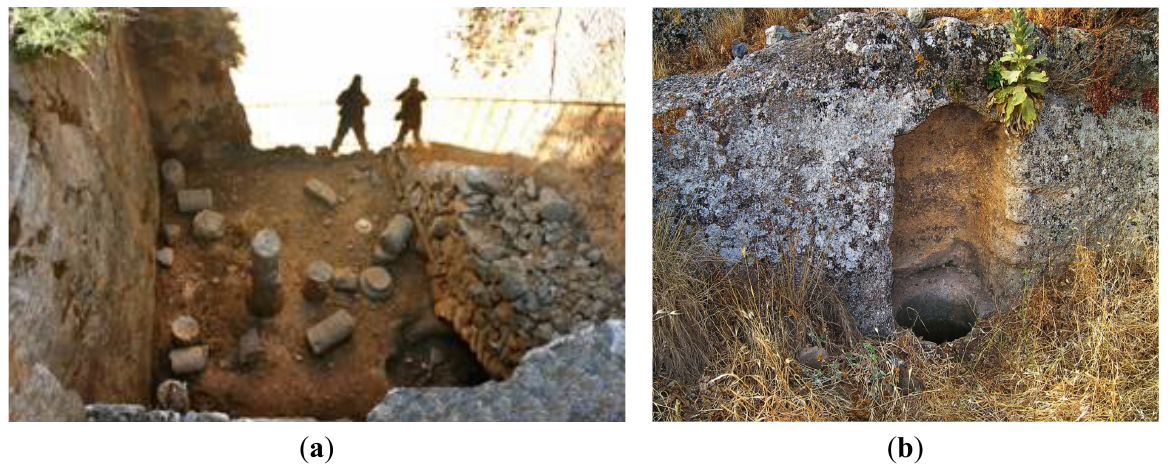
Figure 6. Hellenistic cisterns on Crete: ( a ) cistern in the town of Lato and ( b ) carved cistern in the town of Polyrrhenia (with permission of A.N.